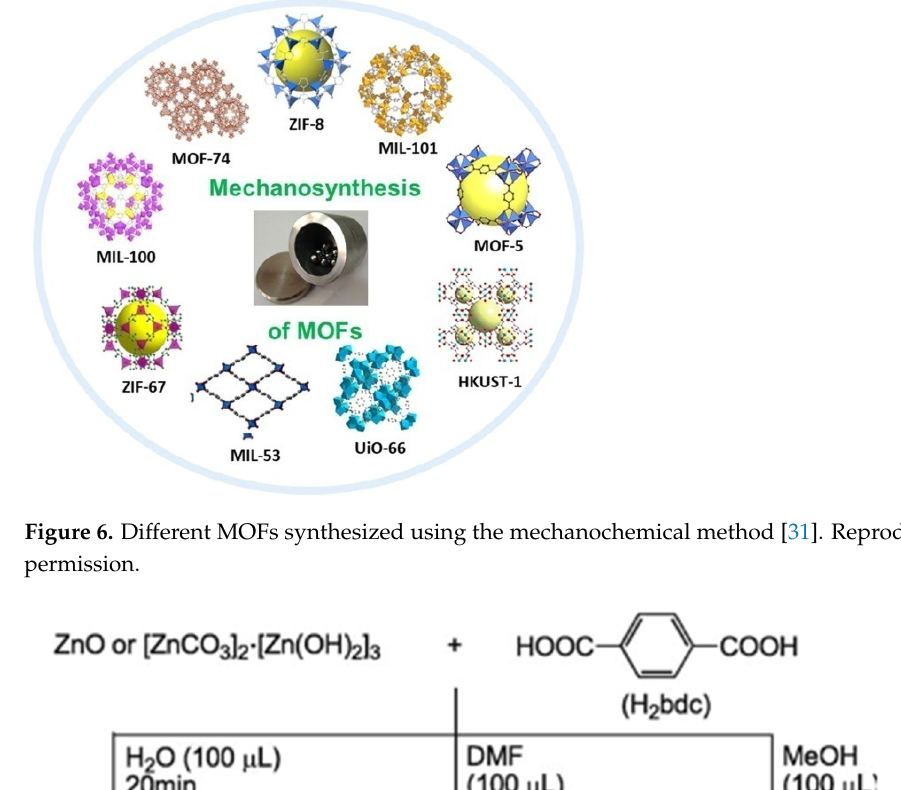
Figure 5. Electrochemical method for MOF synthesis [29]. Reproduced with permission.